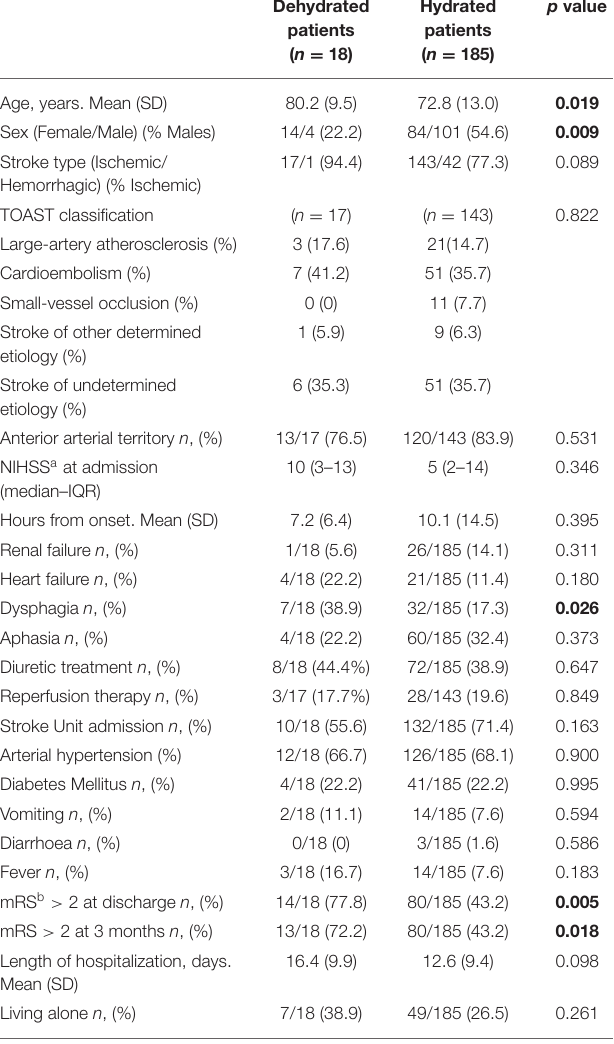
TABLE 1 | Comparison of clinical features in patients classified as either dehydrated or non-dehydrated during hospital admission and p -values from statistical analysis.